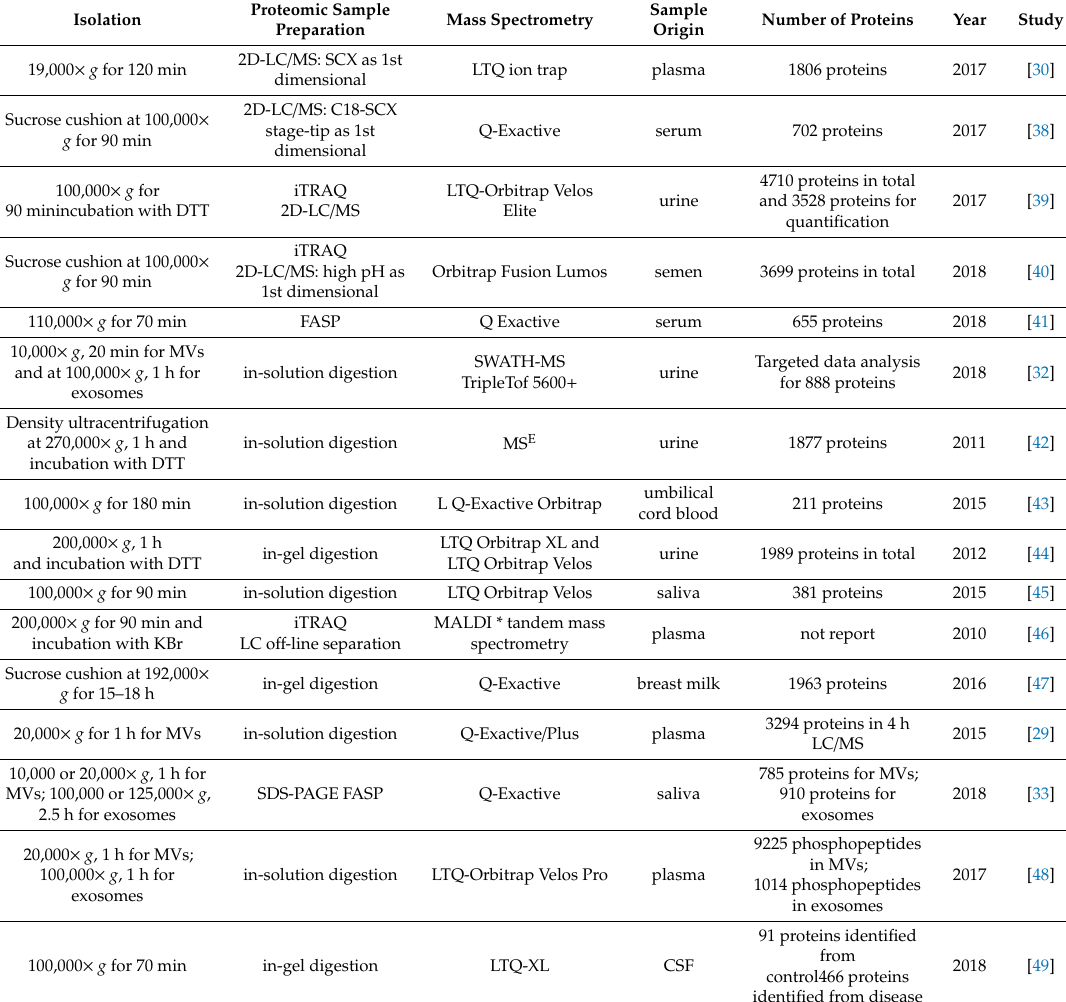
Table 1. Selected MS analysis for EVs obtained from centrifugation-based